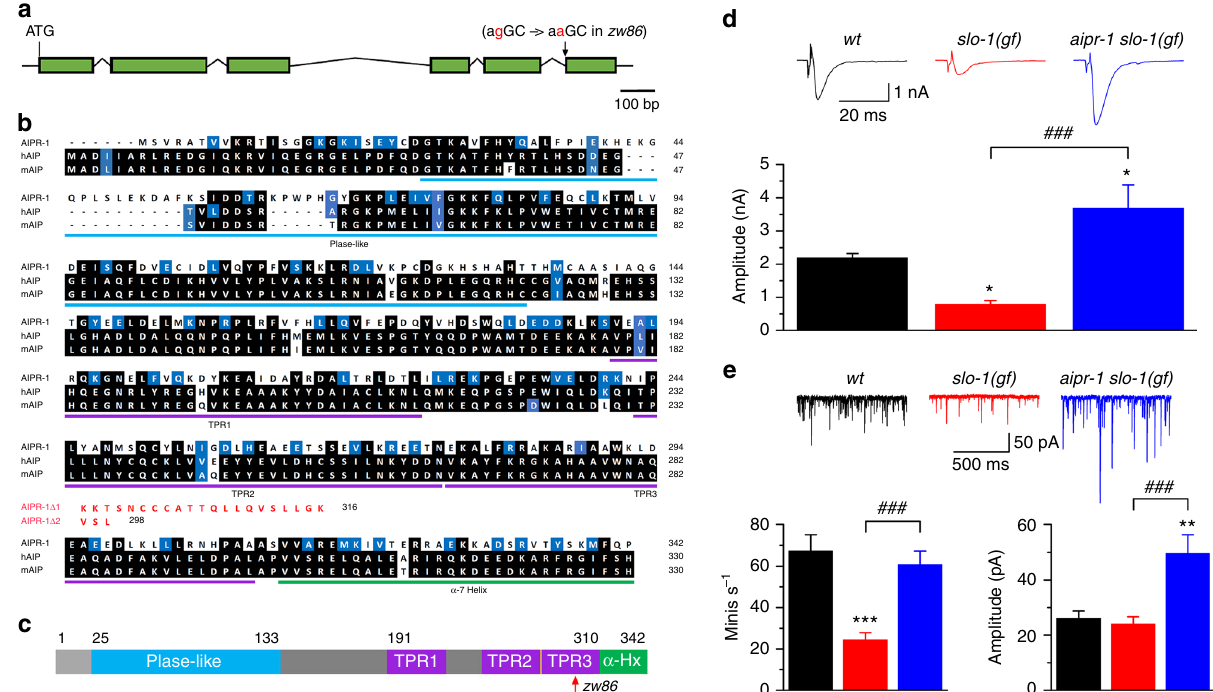
Fig. 1 The effects of aipr-1(zw86) mutation on synaptic phenotypes of slo-1 gain-of-function ( gf ). a Schematic diagram showing the exon and intron organization of aipr-1 (GenBank: NP_495339.1). zw86 is a G to A transition in the splice acceptor site before the last exon. b Alignment of amino acid sequences between AIPR-1, human AIP (hAIP) (GenBank: ACN38897.1), and mouse AIP (mAIP) (GenBank: AAH75614.1). AIPR-1 is 35% identical to hAIP. Identical residues are highlighted in black, whereas similar ones (in size, acidity, or polarity) in blue. The p rolyl cis – trans isomerase-like domain (PIase-like), tetratricopeptide repeat (TPR) motifs, and the C-terminal α -7 helix ( α -Hx) of the TPR repeat structure are underlined. aipr-1(zw86) does not make wild- type AIPR-1 but may produce two alternative isoforms truncated after glutamate (E) 295 (AIPR-1 Δ 1 and AIPR-1 Δ 2) with additional out-of-frame amino acid residues. c Diagram of AIPR-1 domain structure. The red arrow indicates the location of AIPR-1 truncation in zw86 . d Comparison of evoked current amplitude among wild-type ( wt ), slo-1(gf) , and the slo-1(gf) aipr-1(zw86) double mutant. n = 8 in all groups. e Comparison of the frequency and mean amplitude of spontaneous minis among the three groups. n = 8 in all groups. Data are shown as mean ± SEM. * p < 0.05, ** p < 0.01, *** p < 0.001 compared with wt ; ### p < 0.001 compared between with slo-1(gf) (one-way ANOVA followed by Tukey ’ s post-hoc